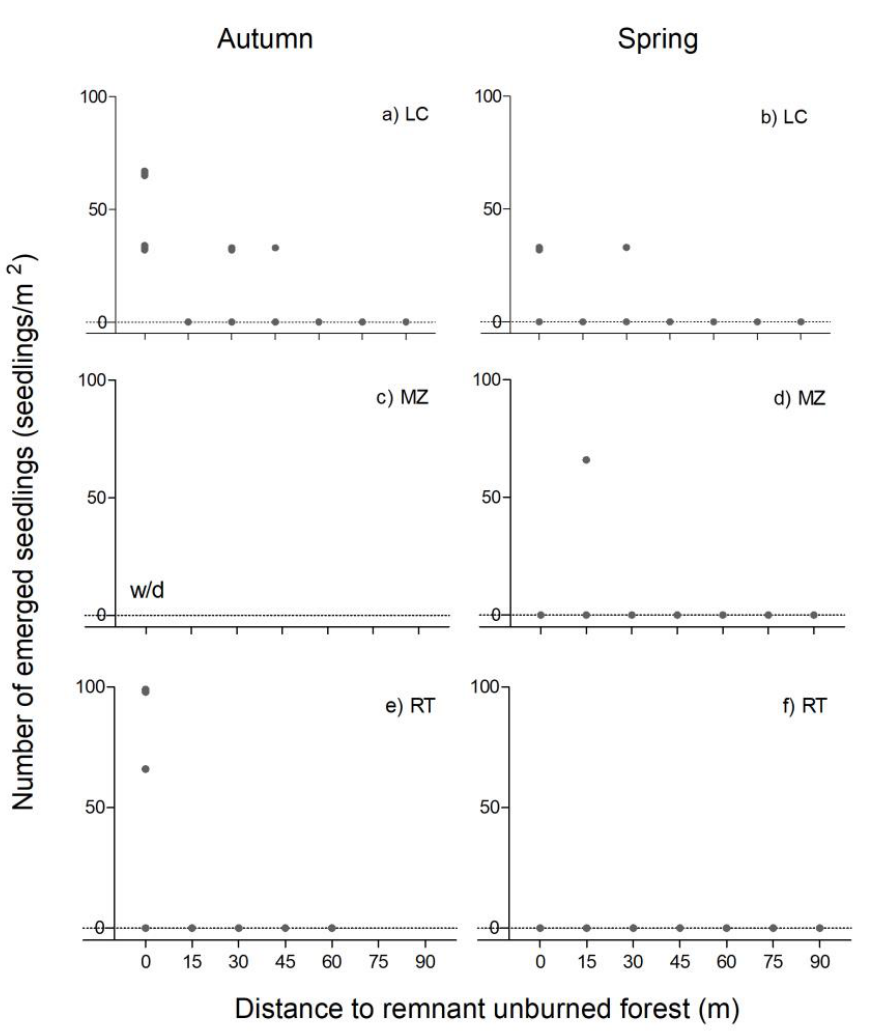
Figure 3. Emergence of N. pumilio seeds in La Colisión (LC, ( a , b )), Monte Zeballos (MZ, ( c , d )), and Río Turbio (RT, ( e , f )), as a function of the distance from the edge of the remnant forest to the burned area, in autumn (left) and spring (right). Dots represent the observed emergence in each sample soil. w/d: without data.